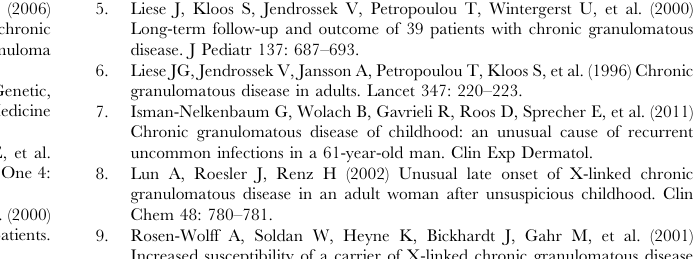
A Complete NADPH